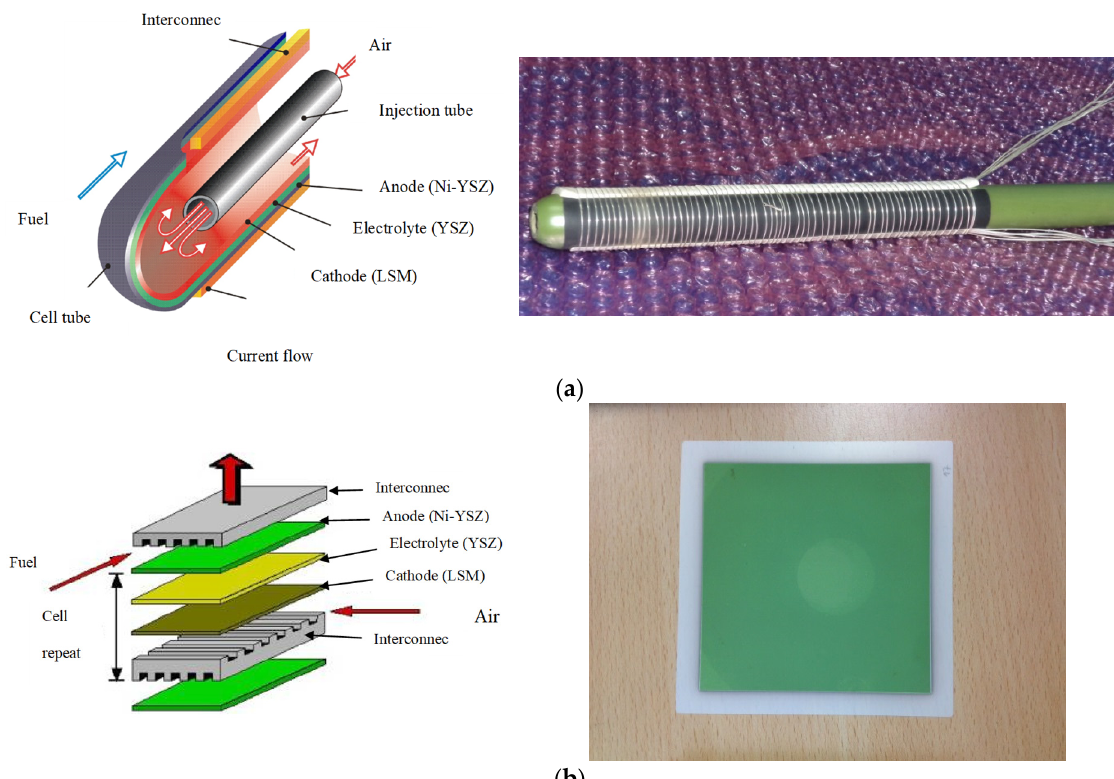
Figure 4. Schematic of: ( a ) tubular SOFC and ( b ) planar SOFC (figure reprinted from Hajimolana et al. [6] Copyright (2011), with permission from Elsevier).